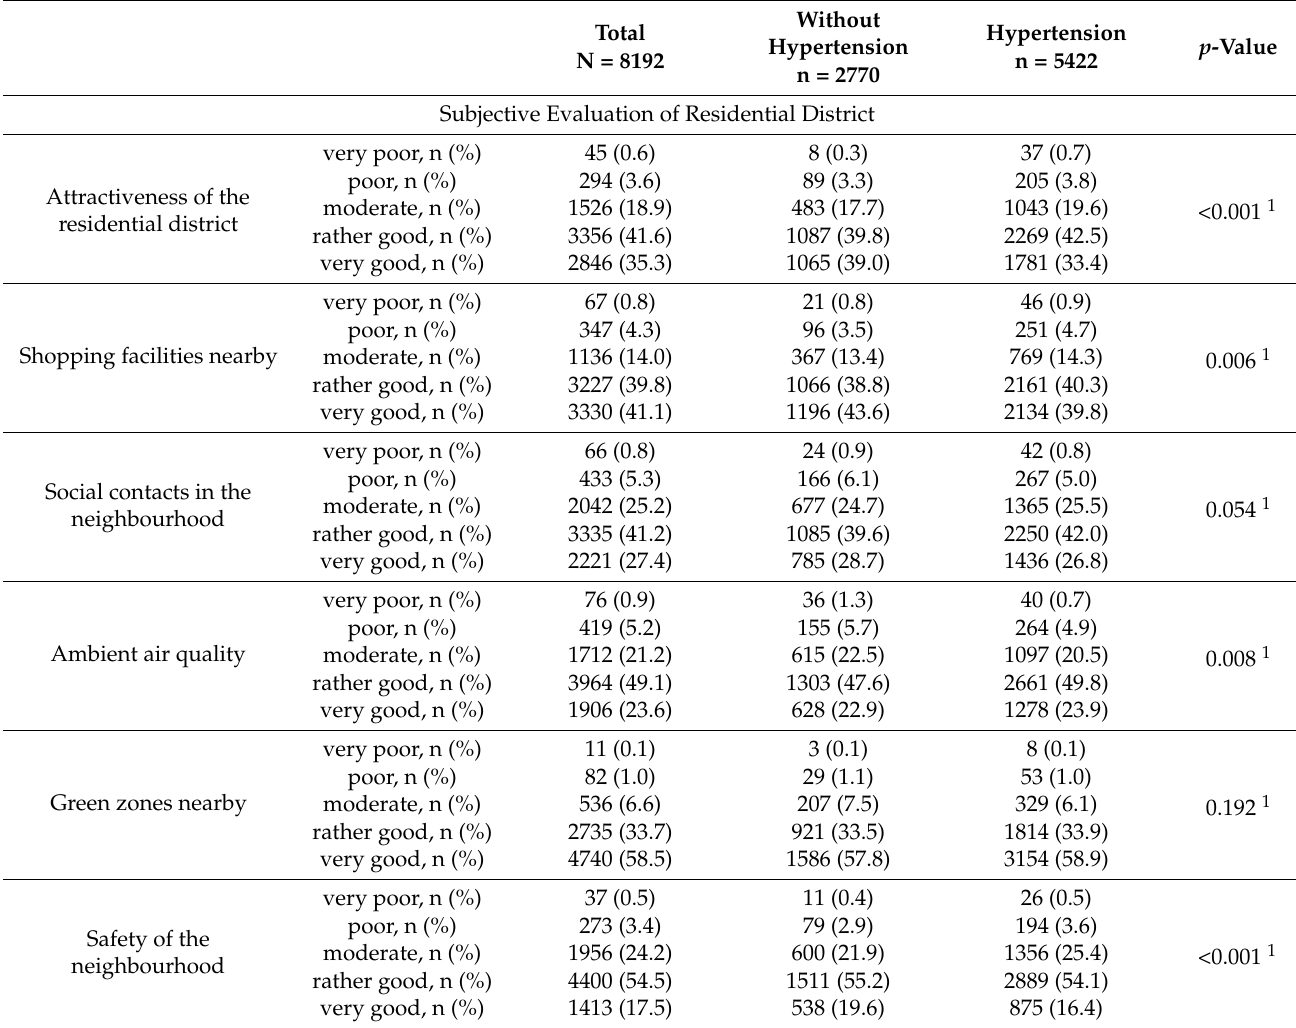
Table 4. Subjective evaluation of residential